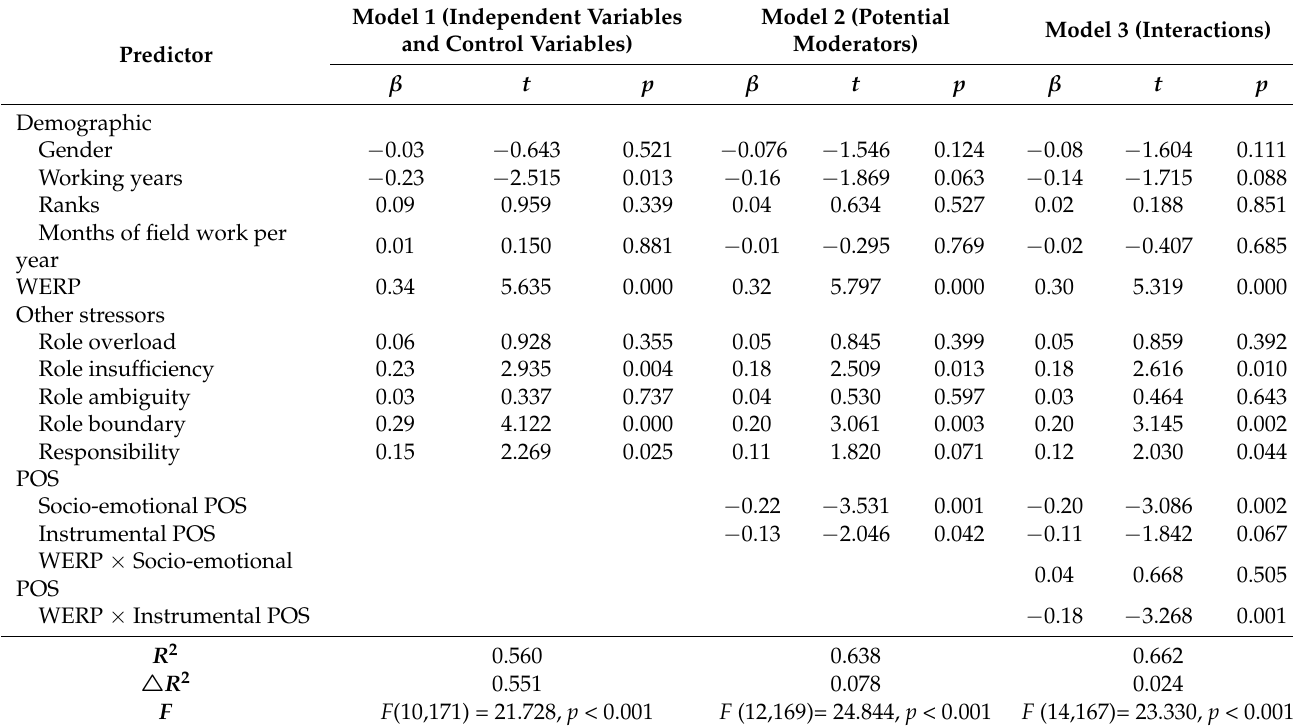
Table 3. Hierarchical multiple regression predicting occupational strain from working environmental risk perception and perceived organizational